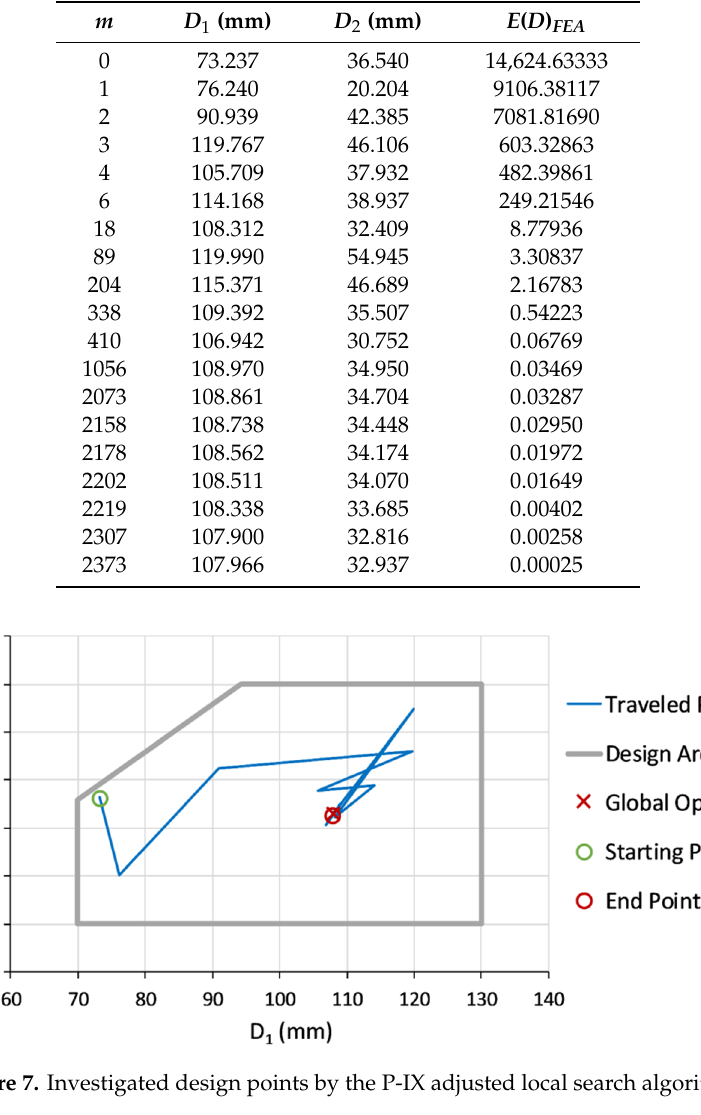
Table 9. Better function values accepted by P-IX adjusted local search algorithm.